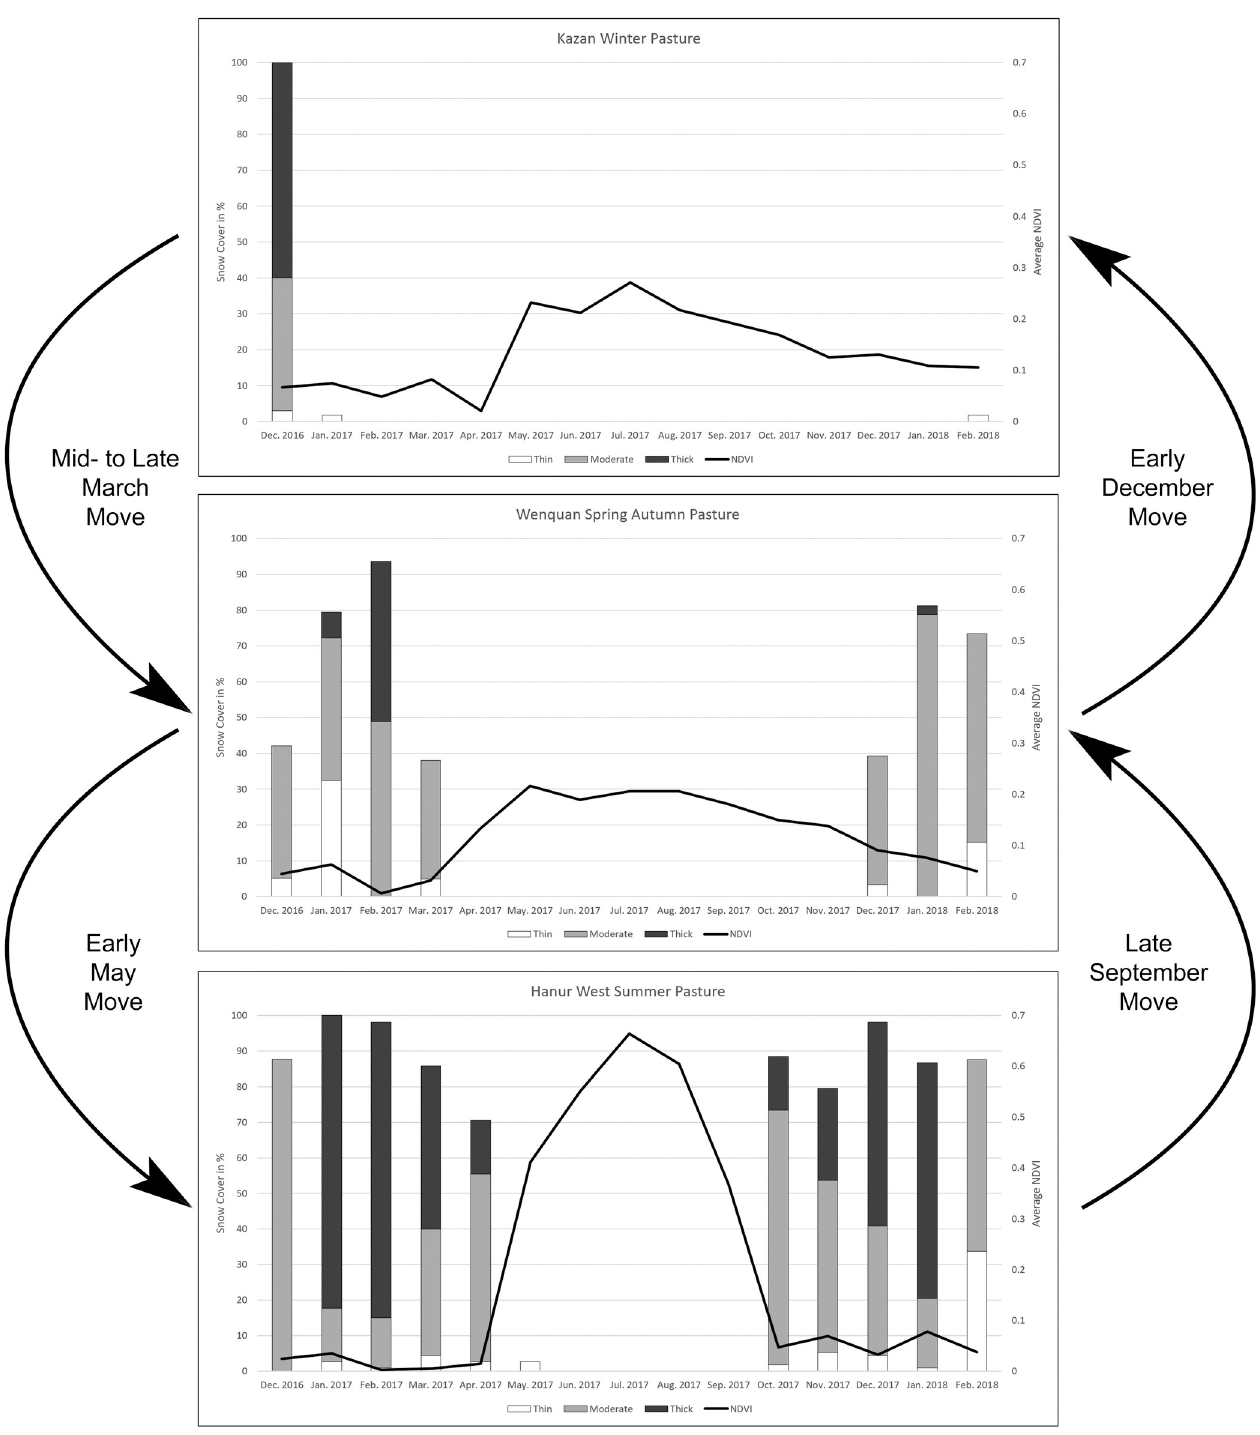
Fig 11. Idealised pastoralist movements based on ethnographic and remote sensing data. Left y-axis: snow cover in % displayed as a bar diagram distinguishing thin/moderate/thick snow cover. Right y-axis: average NDVI value.